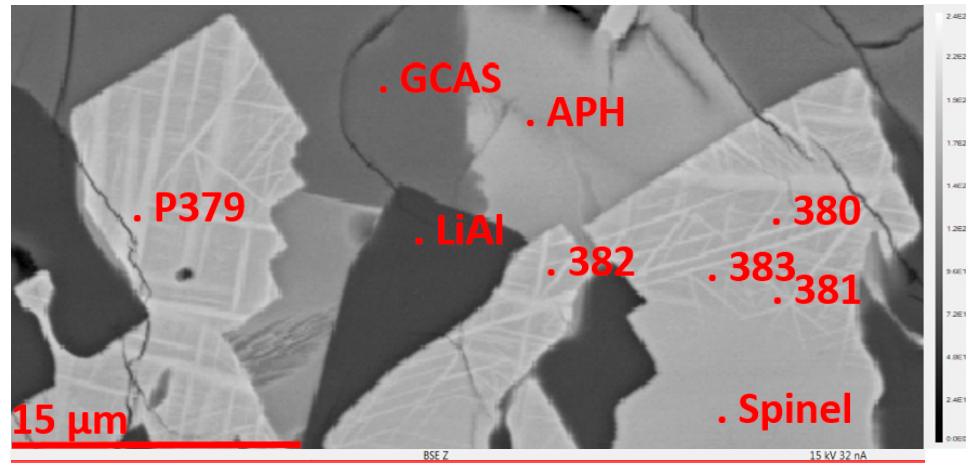
Figure A2. Close-up of Figure 4 showing the lamellae region.